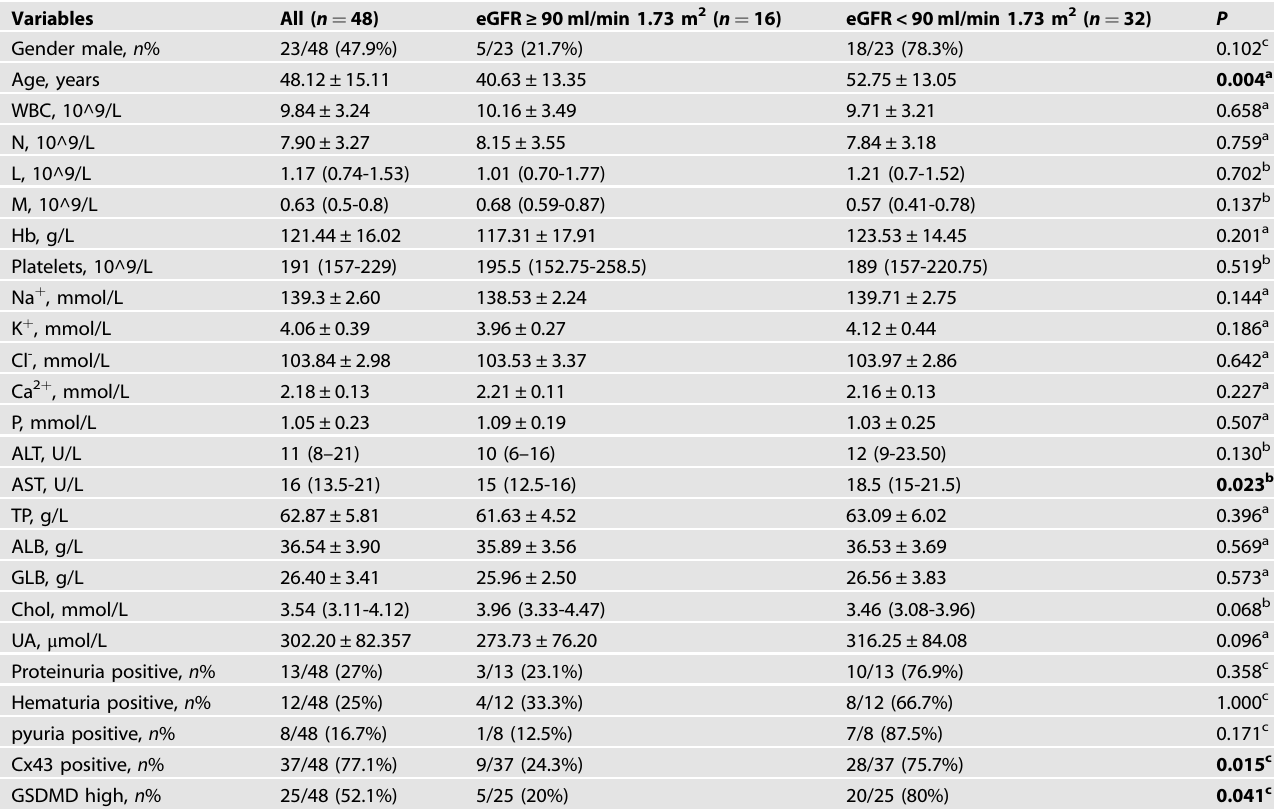
Table 1. Obstructive nephropathy patients in the Cx43 positive group and GSDMD high group showed a decline of kidney function. Variables